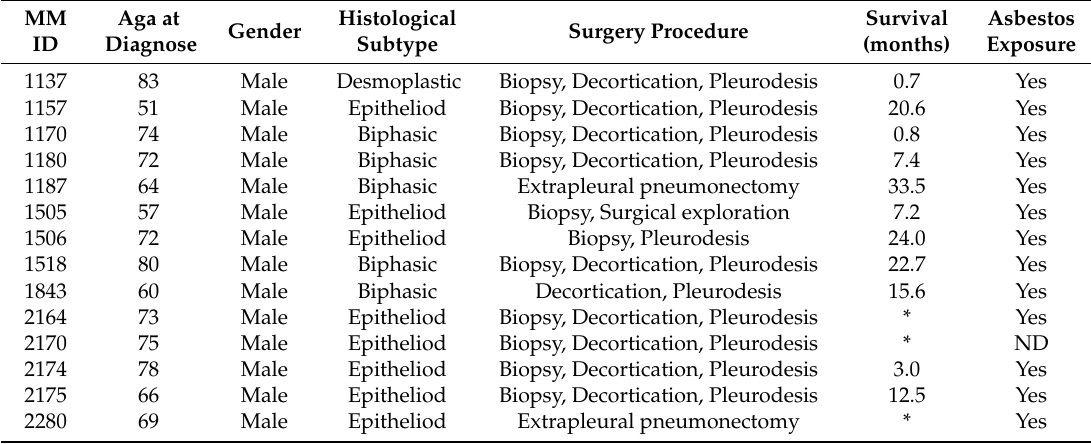
Table 3. Patient